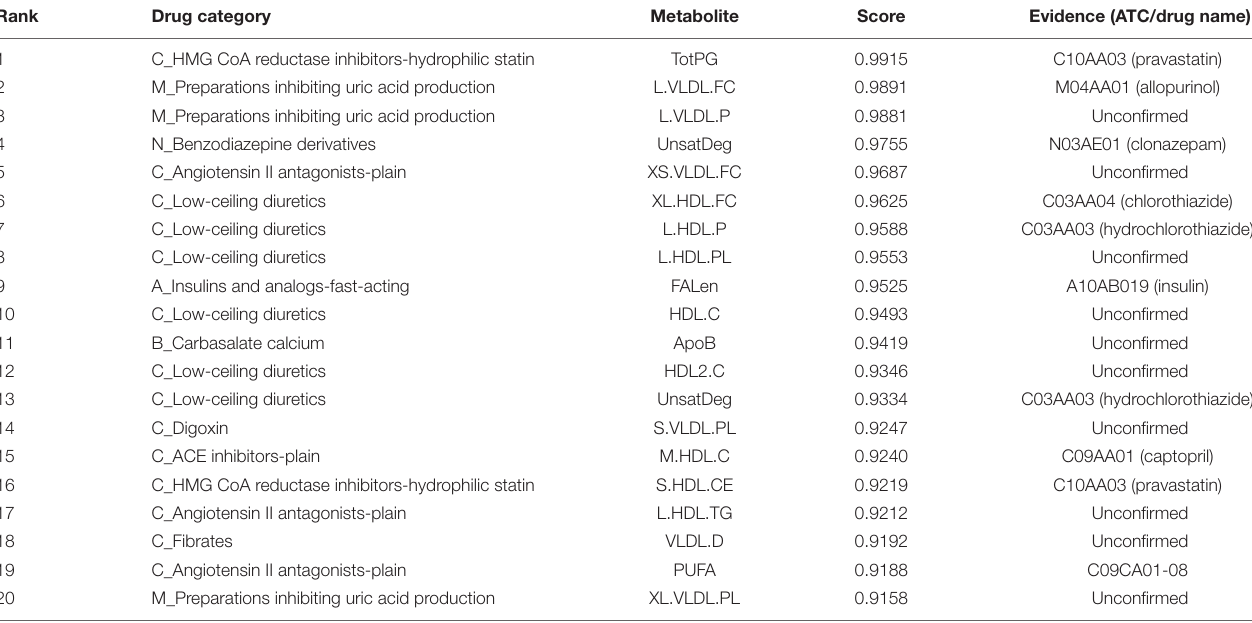
TABLE 3 | Top 20 novel associations predicted by ILMF on the “DrugMetaboliteAtlas” dataset.